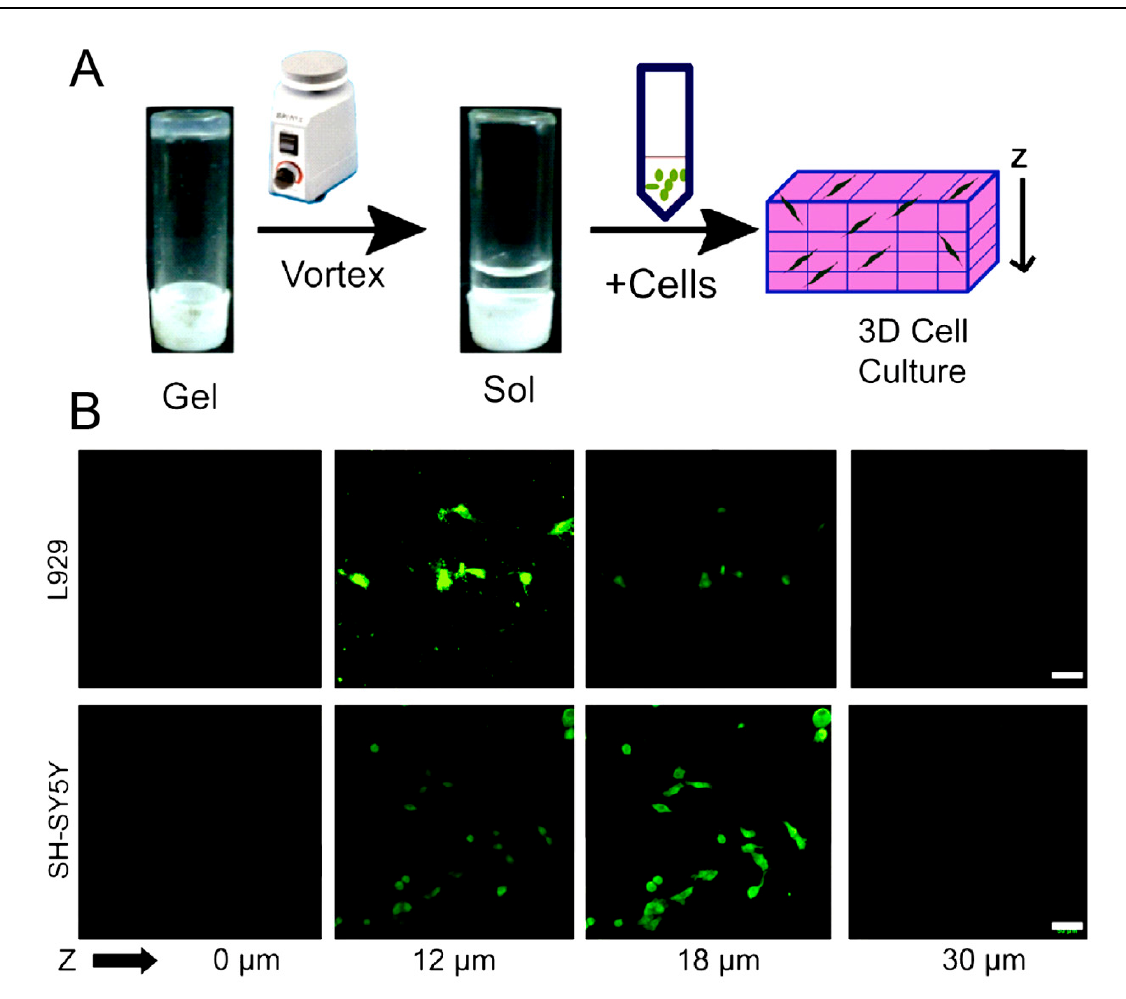
Figure 4. ( A ) Schematic depicting entrapment of cells inside thixotropic peptide gels. ( B ) 3D cell culture using hydrogel showing cell viability of both SH-SY5Y and L929 cells indicated by calcein-AM staining (green) inside the 3D gel matrix. Scale bars are 50 mm. Reprinted with permission from Ref. [178] ; Copyright 2015, Elsevier.